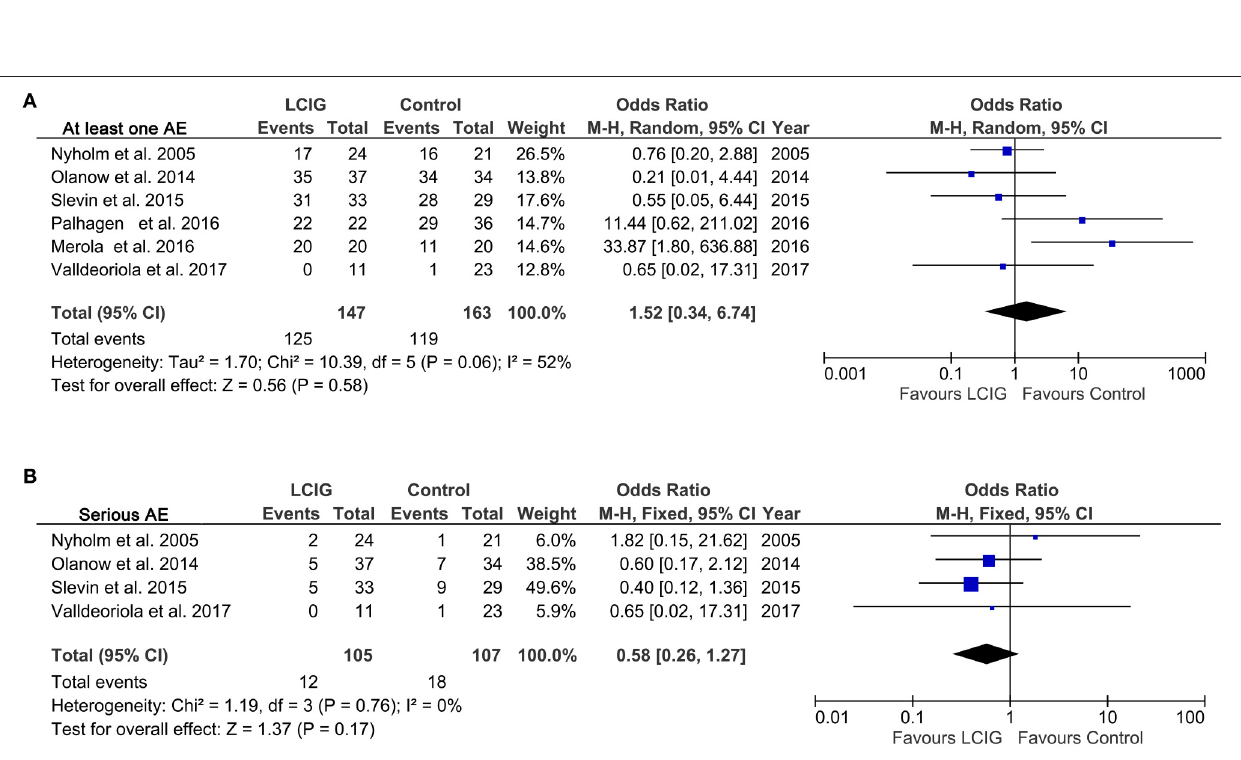
Frontiers in Neurology | www.frontiersin.org